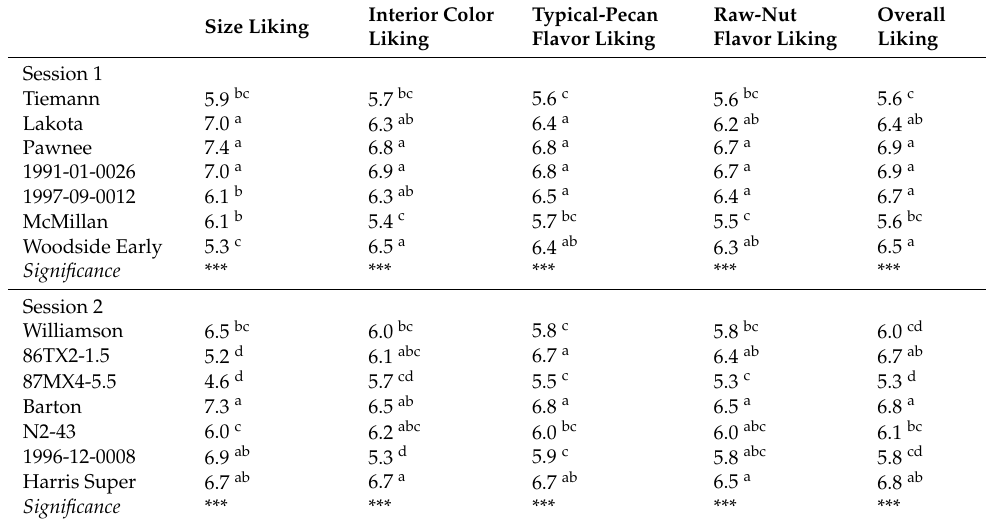
Table 1. Mean scores of five liking attributes for the consumer tests of 14 pecan varieties. Interior Color Typical-Pecan Raw-Nut Size Liking Liking Flavor Liking Flavor